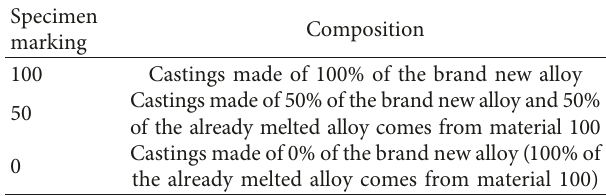
Table 1: Marking of the specimens.